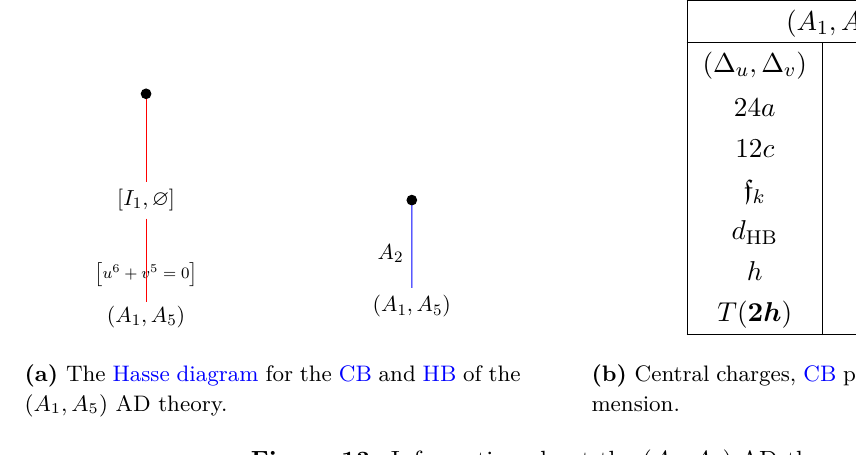
Figure 13. Information about the ( A 1 , A 5 ) AD